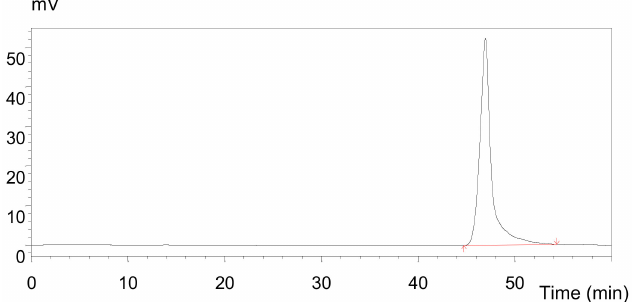
Figure 5. HPLC with tandem gel column profiles of aAAP-1.